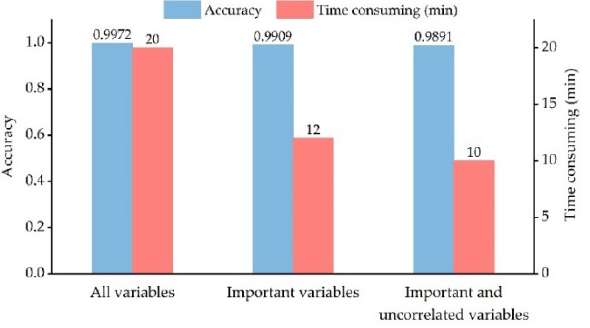
Figure 8. Parameter search results of XGBoost models under three variable combinations.